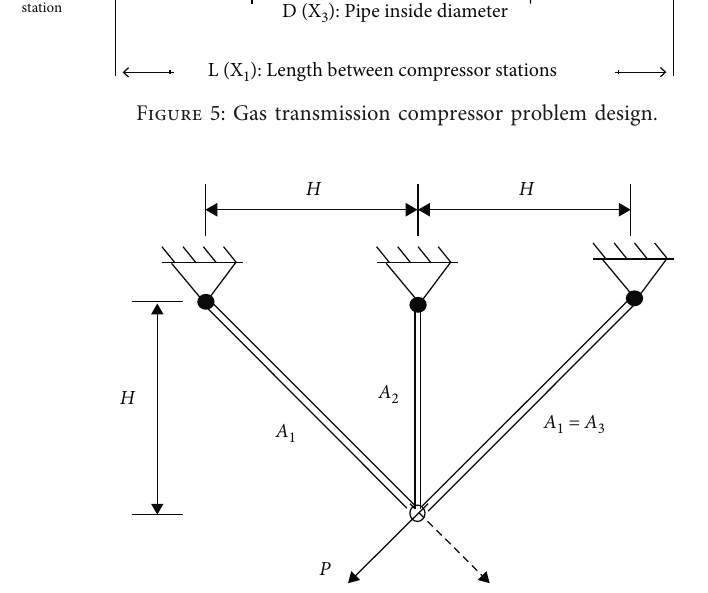
Figure 6: Three-bar truss problem design.